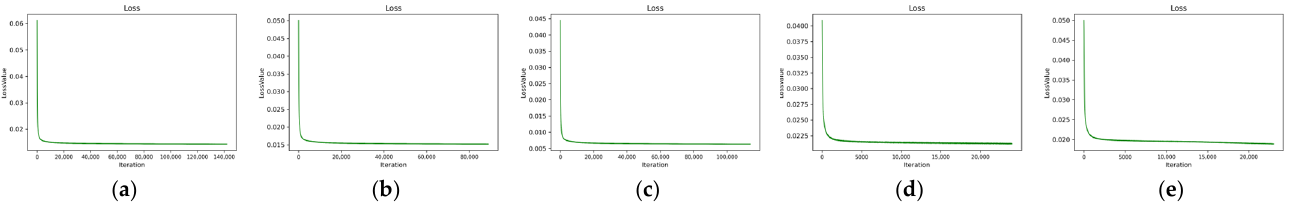
Figure 20. Relationship between loss value and the number of iterations for: ( a ) Case 1 1 , iterations = 142,000; ( b ) Case 1 2 , iterations = 89,000; ( c ) Case 2, iterations = 114,000; ( d ) Case 3, iterations = 24,000; and ( e ) Case 4, iterations = 23,000.